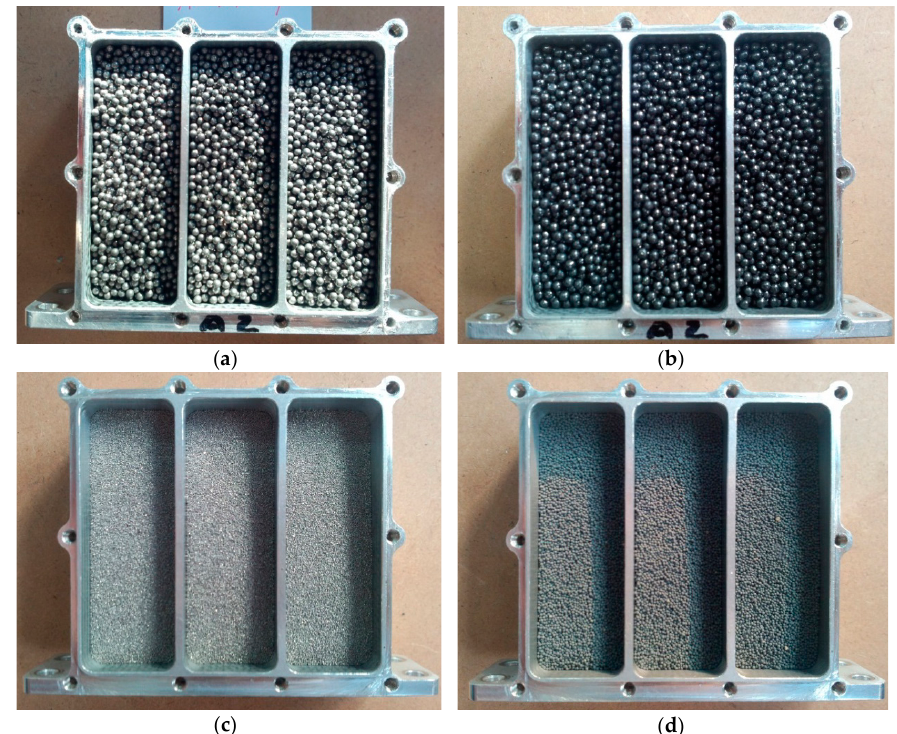
Figure 5. Particle type ( a ) 304 Stainless steel particles (2 mm diameter); ( b ) Lead particles (2 mm diameter); ( c ) Stainless steel powder (about 0.048 mm diameter); ( d ) Tungsten carbide powder (about 0.5 mm diameter).